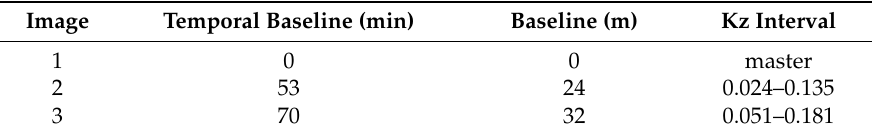
Table 1. Description of airborne PolInSAR